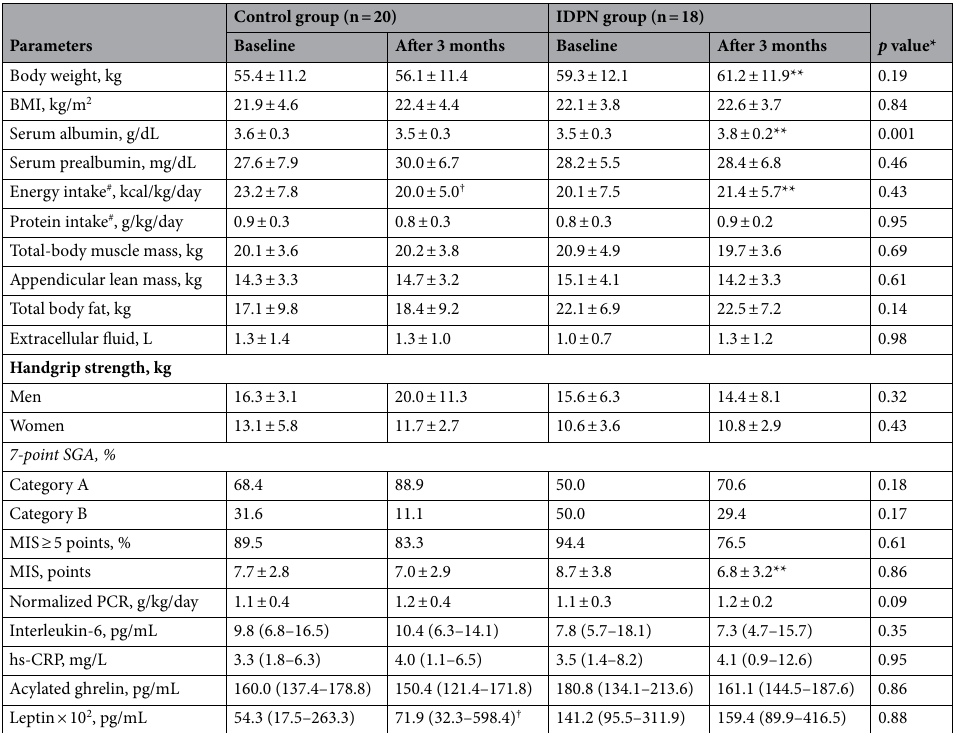
Table 2. Comparison of changes of primary and secondary outcomes between two groups. 7-point SGA category A and B defined as well-nourished and mild to moderately malnourished, respectively. BMI Body mass index, hs-CRP High sensitivity C-reactive protein, PCR Protein catabolic rate. MIS ≥ 5 indicated at risk for protein energy wasting. # Spontaneous energy and protein intake. Data are presented as mean ± SD and median (25th–75th). * p value between groups comparison at month 3. ** P < 0.01 after 3 months in the IDPN (intervention) group compared with baseline. † P < 0.05 after 3 months in the control group compared with